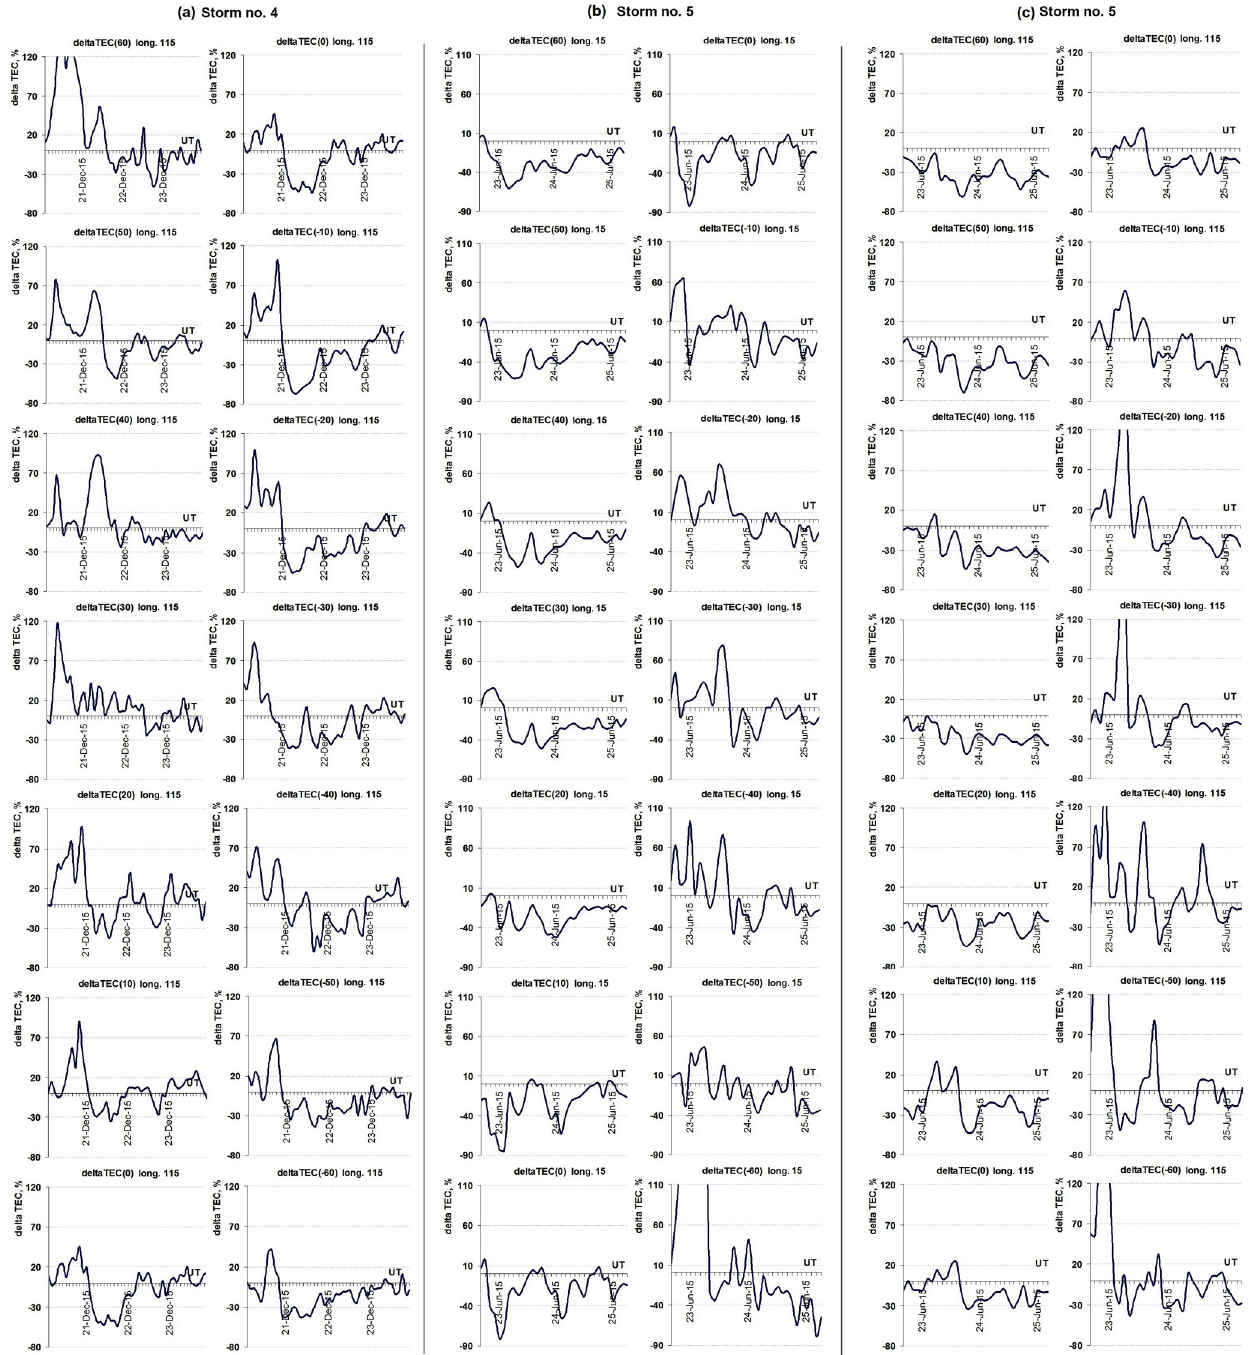
Figure 4. δ TEC variations for storms as follows: (a) no. 4 along the Asian-Australian meridian, (b) no. 5 along the Euro-African meridian and (c) no. 5 along the Asian-Australian meridian. The left-hand plots of columns a, b and c display variations in the Northern Hemisphere and the right-hand plots display variations in the Southern